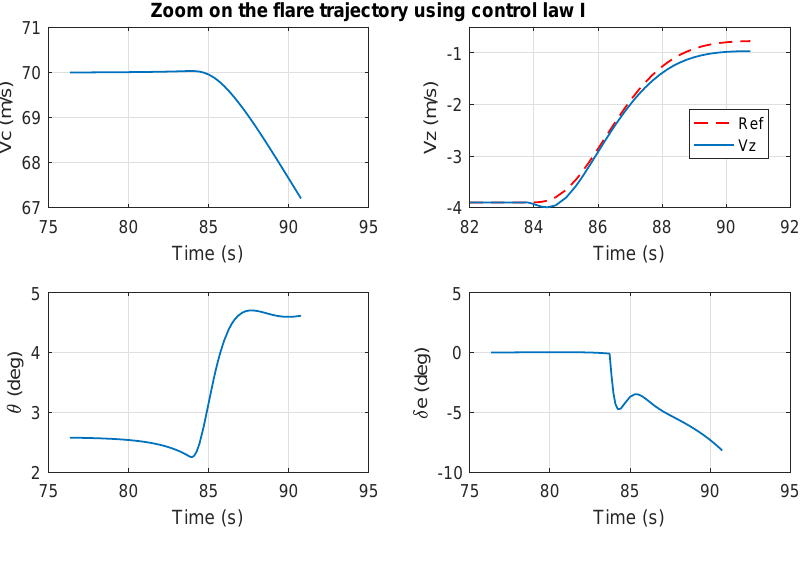
Figure 6. Flare trajectory with Control Law I (without speed